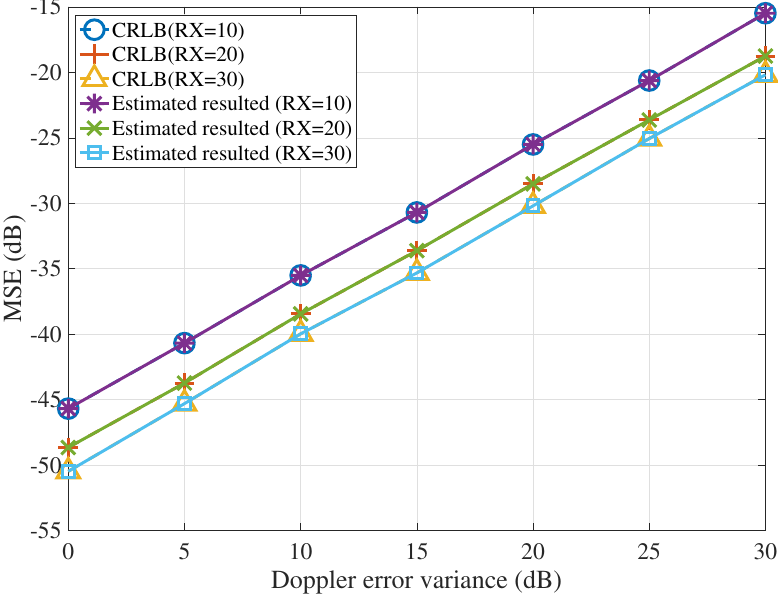
Figure 3. Target velocity estimation performance without position errors.